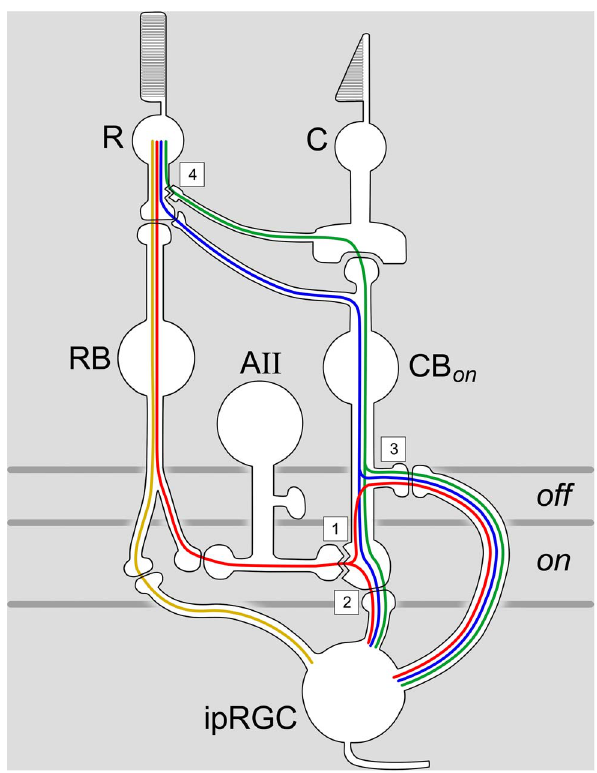
Figure 9. Schematic summary of pathways by which rod signals could reach ipRGCs. The ipRGC is a hybrid of known melanopsin- expressing ganglion cell types, some of which stratify exclusively in the uppermost OFF sublayer (site 3), others in the ON sublayer (e.g., site 2), and still others in both (see text). Jagged lines represent gap junctional contacts between AII amacrine cells and ON cone bipolar terminals (site 1) and between rods and cones (site 4). The primary rod pathway is shown in red , the secondary rod pathway in green , and a novel pathway from rods to ON cone bipolar cells in blue [35]. All of these pathways have been considered to relay to ganglion cells in the ON sublayer (site2), but they may also pass through ectopic ON cone bipolar terminals in the OFF sublayer to the dendrites of some ipRGCs (site 3; see text). A pathway directly linking rod bipolar cells to ipRGCs, proposed by Ostergaard et al. (2007) [17], is shown in gold . R: rod; C: cone; RB: rod bipolar cell; CBon: ON cone bipolar cell; AII: AII amacrine cell; ipRGC: intrinsically photosensitive retinal ganglion cell. Horizontal gray lines indicate the ON and OFF sublayers of the inner plexiform